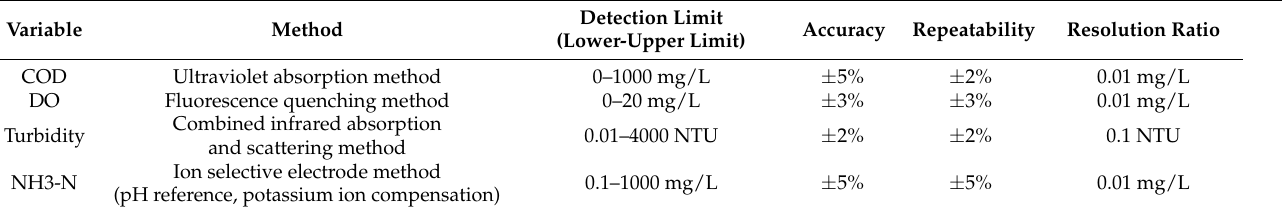
Table 2. Detailed parameters of four underwater sensors.